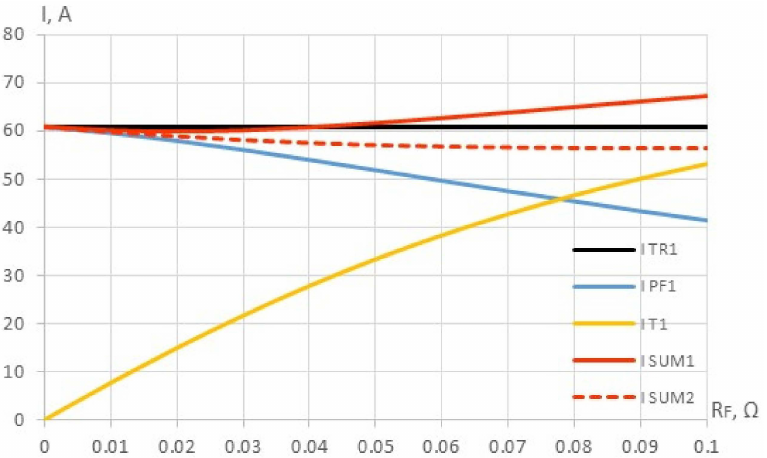
Figure 5. The dependences of the 5th harmonic currents I TR1 , I T1 , I PF1 , I SUM1 , I SUM2 on the passive filter resistance R F